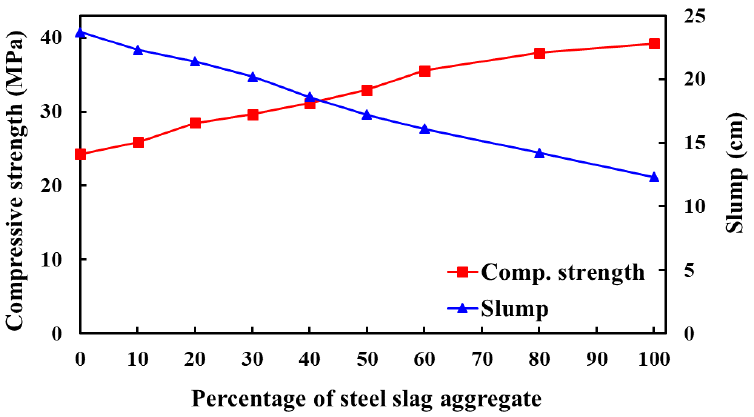
Figure 4. Slump and compressive strength of concrete made with different percentages of IFSSA.